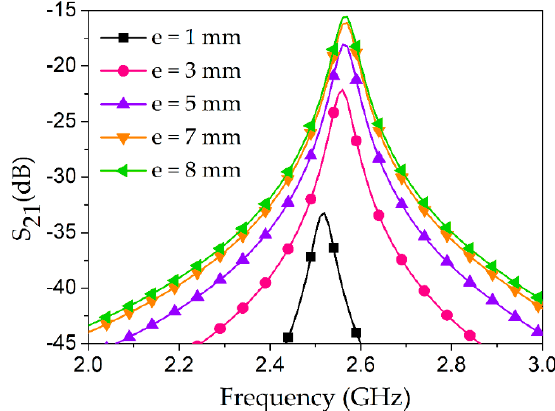
Figure 6. Various lengths of bare inner conductor ( e ) of the coaxial coupling probe were investigated, where the coupling gap was fixed as g = 2 mm in this set of simulations. Inset shows the top view of the assembly for the case when e = 7 mm. The bare inner conductor of the coaxial cable is not radiating as a monopole antenna and it does not contribute to the high transmission coefficient (or reduced losses), thus ensuring that the length of the coaxial cable is less than one wavelength ( λ ), and the length of the bare inner conductor is less than λ /4.